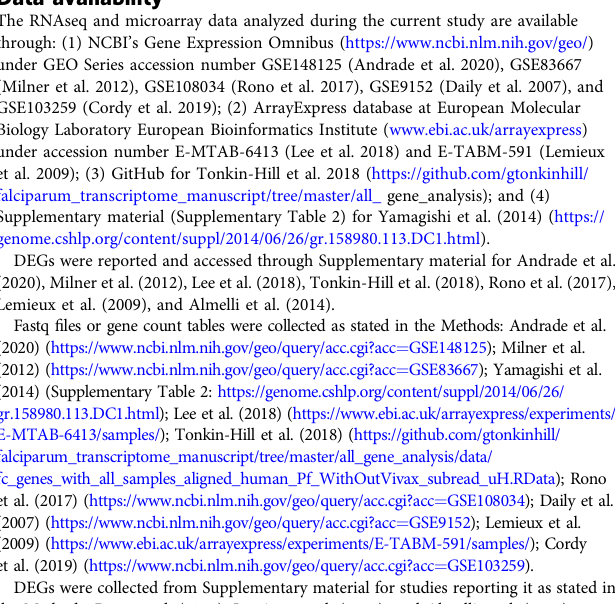
(2014) (Supplementary Table 2: https://genome.cshlp.org/content/suppl/2014/06/26/ gr.158980.113.DC1.html); Lee et al. (2018) (https://www.ebi.ac.uk/arrayexpress/experiments/ E-MTAB-6413/samples/); Tonkin-Hill et al. (2018) (https://github.com/gtonkinhill/